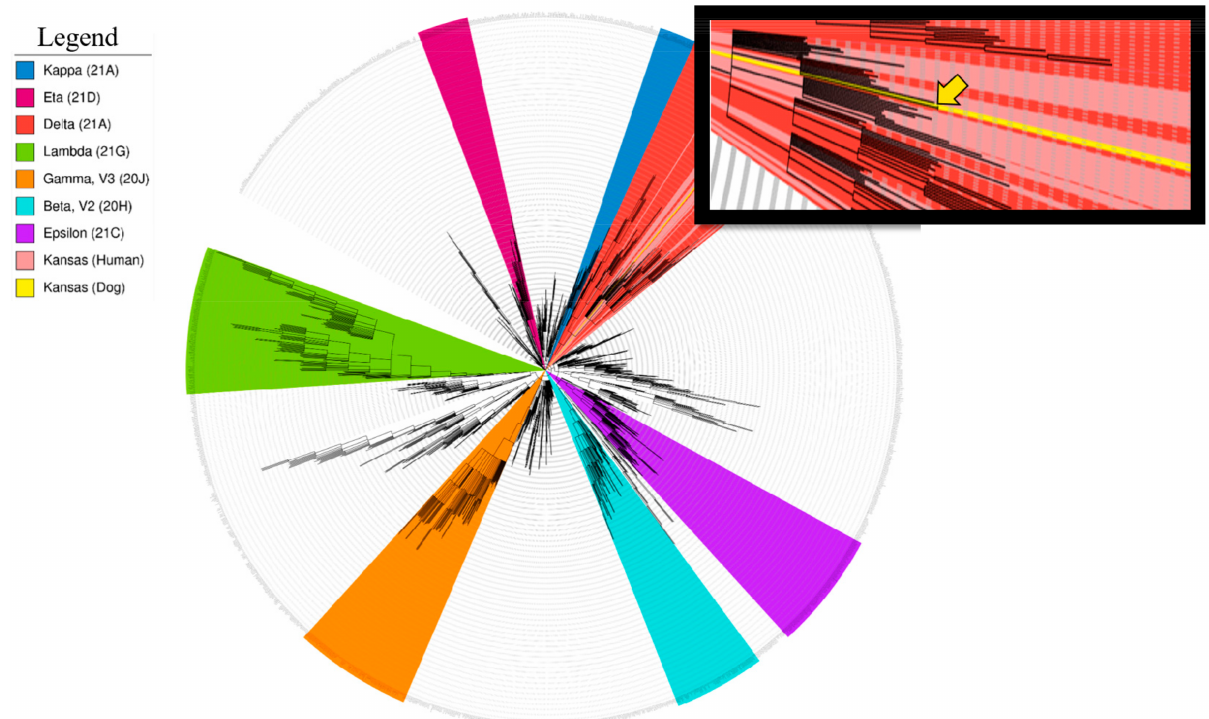
Figure 2. Phylogeny of hCoV-19/dog/USA/KS-8074/2021. The phylogenetic tree was constructed using the Nextclade pipeline, run on a local server using a GTR model. The tree was modified in iTOL. SARS-CoV-2 lineages are illustrated using the following color scheme: kappa, blue; eta, maroon; delta, red; lambda, green; gamma, orange; beta, turquoise; epsilon, purple. The SARS-CoV-2 genomes obtained from people in Manhattan, KS, are indicated in light red. The SARS-CoV-2 dog genome is indicated in yellow in the main figure and with a yellow arrow in the inset. Variants of concern (VOCs) alpha, beta, gamma, epsilon, and delta